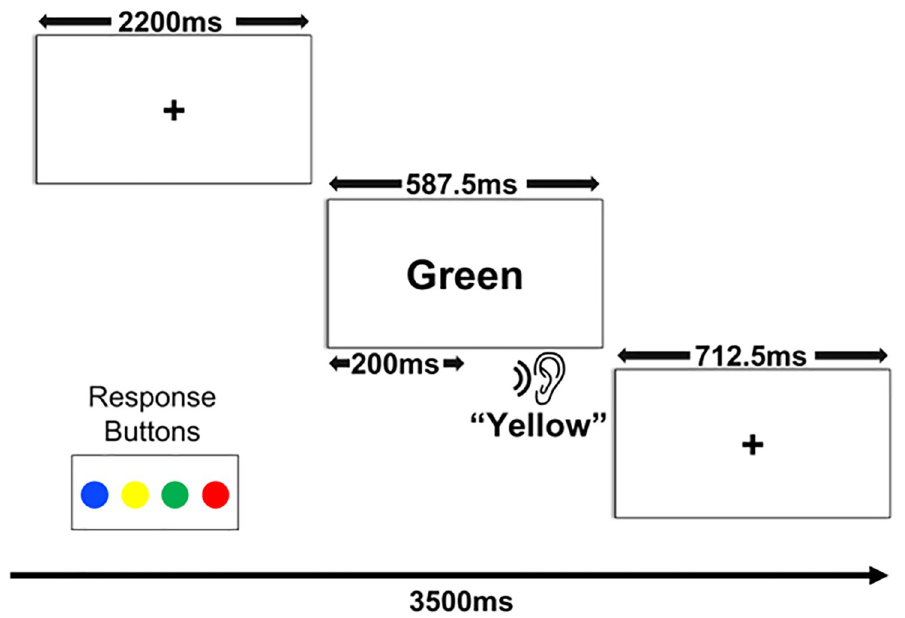
Fig 1. Schematic of experimental design. Visual representation of a single trial of the experimental AV Stroop task. The figure depicts an example of an incongruent trial wherein the visual and auditory words do not